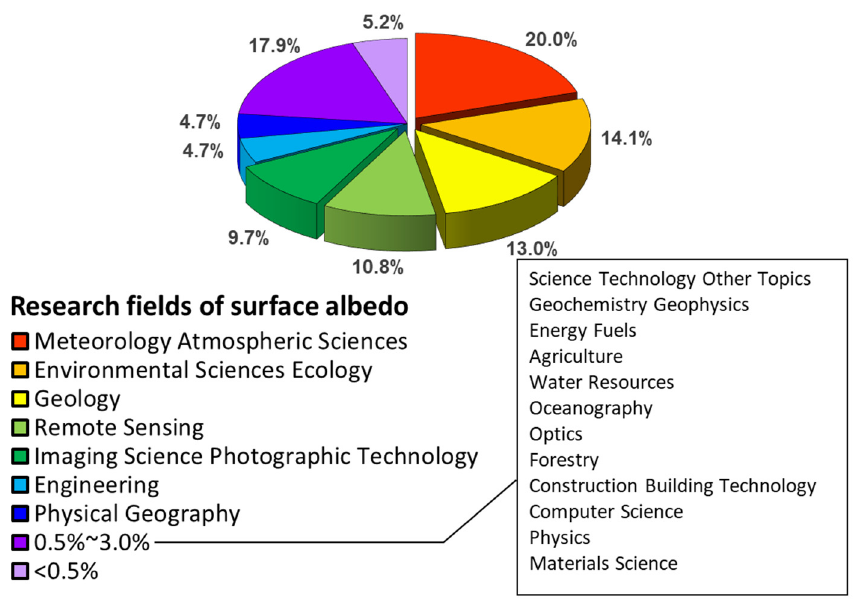
Figure 3. Pie chart of research fields associated with surface albedo.